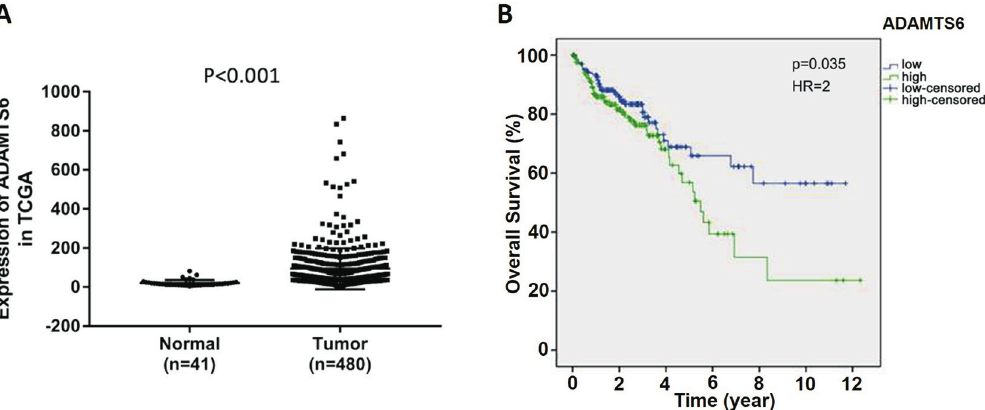
Figure1 -HighexpressionofADAMTS6predictspoorprognosisincoloncancer.(A)ThemRNAlevelofADAMTS6incoloncancertissueandnormal samples. (B) Kaplan-Meier was utilized to analyze the overall survival of ADAMTS6 in colon cancer patients. ADAMTS6 high expression was con- cerned with a worse prognosis in colon cancer relative to the ADAMTS6 low expression